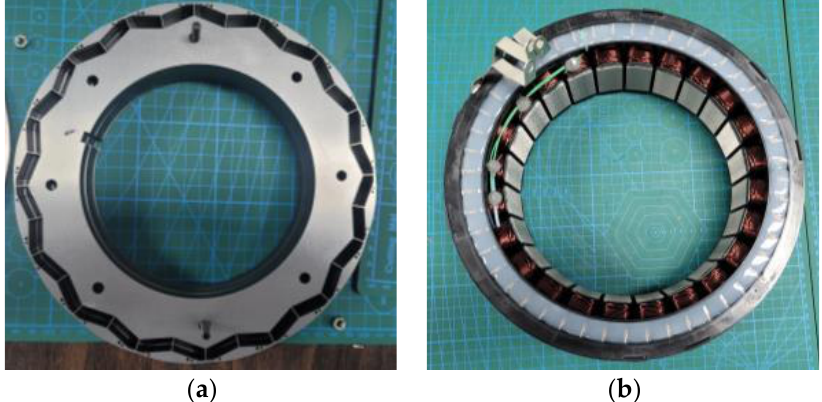
Figure 22. Rotor and stator fabrication pictures; ( a ) rotor; ( b ) stator.